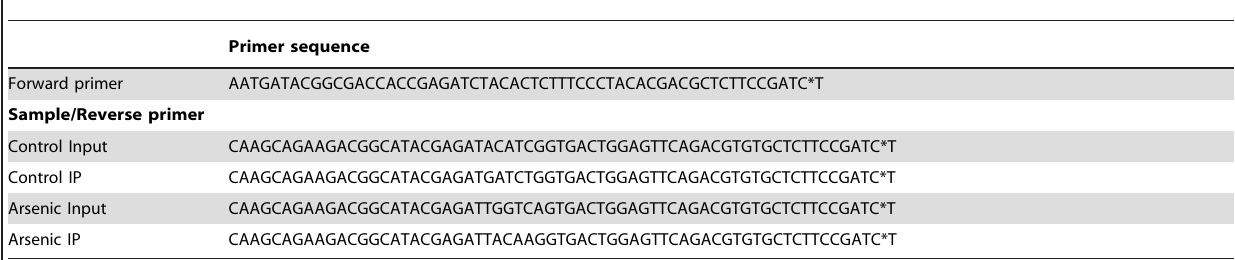
Table 4. Primers used for ChIP library